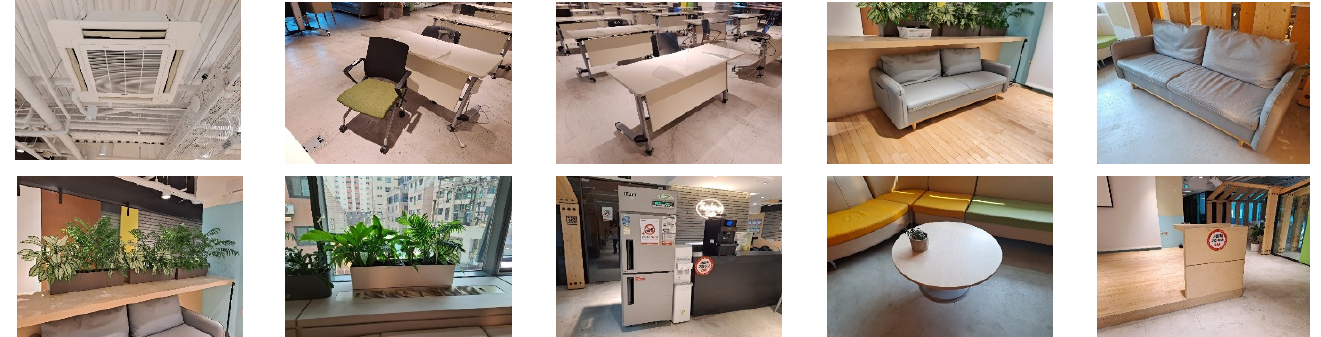
Figure 5. Objects selected for the evaluation, including air conditioner, chair, desk, sofa_1, sofa_2, flower table, flower pot, refrigerator, round table, and podium table.